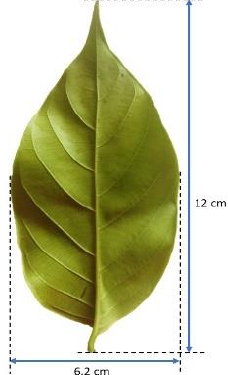
Figure 1. Macroscopic characteristics of Uncaria gambir leaf. Gambir plants, like most other plantation crops, can be propagated vegetatively and generatively. Propagation through the method of cuttings (vegetative) at the location of the mother tree showed low success, namely, 15–40% [26]. In addition, this method is difficult to transport, easily damaged, and sensitive to drought. Another vegetative method, namely layering, can achieve a higher success rate of 80%. This method has the disadvantage that it is difficult to transfer from the parent tree because few roots are formed